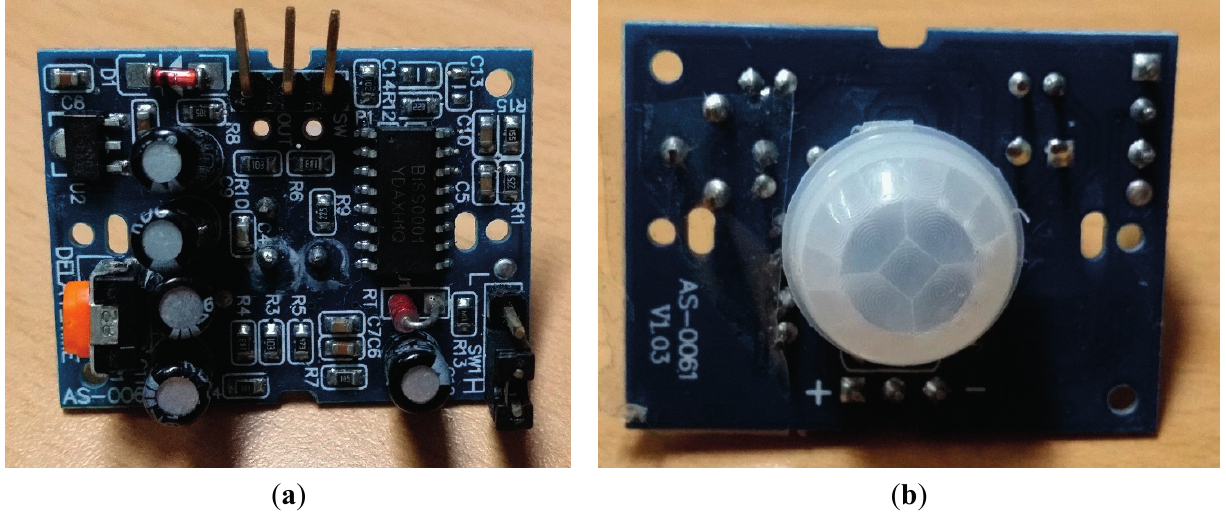
Figure 2. Detection range of Infra-Red motion